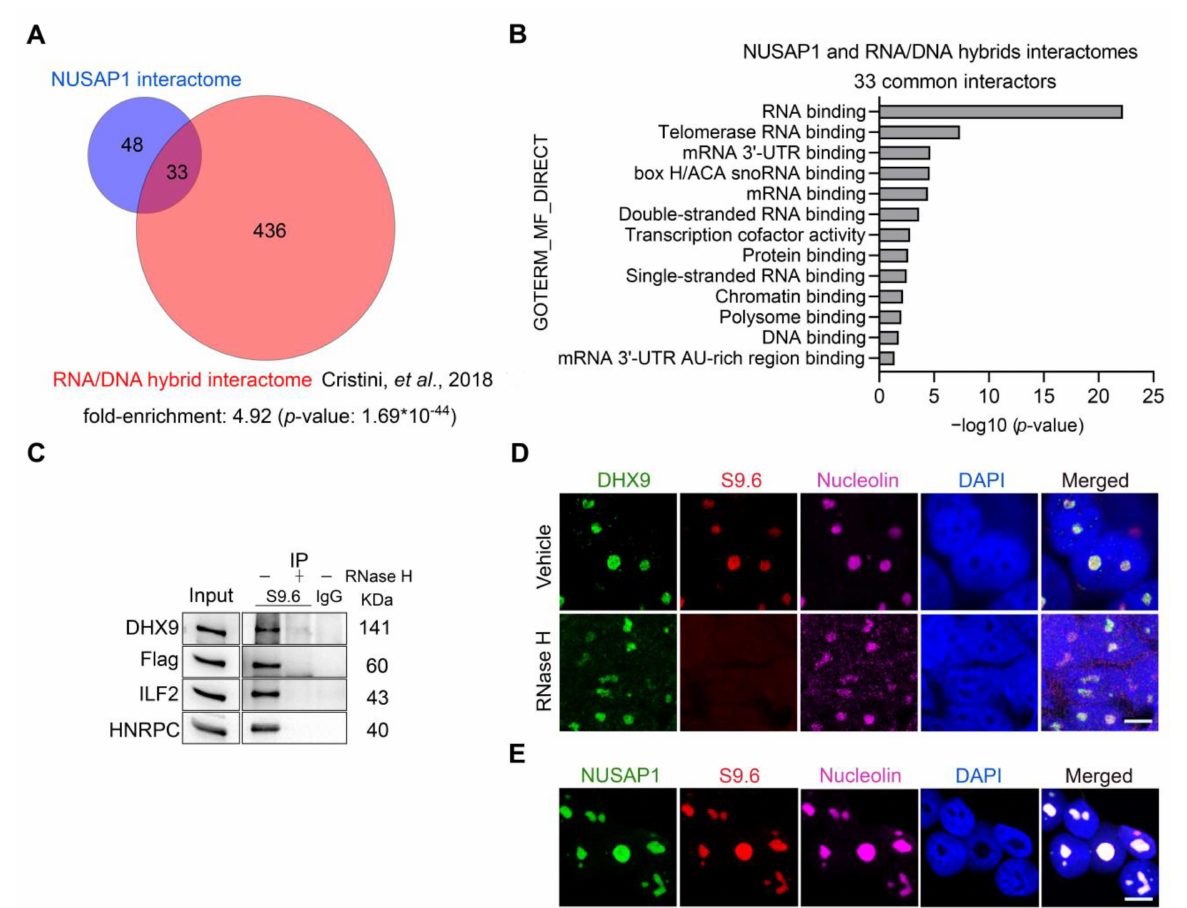
Figure 3. NUSAP1, ILF2, and DHX9 interact with R-loops. ( A ) Venn diagram of 33 proteins found in both NUSAP1 and RNA/DNA hybrid interactomes [41], including ILF2 and DHX9. ( B ) Gene ontology (GO) analysis of the 33 common NUSAP1 and R-loop-interacting proteins shows enrichment for RNA and telomerase RNA binding. ( C ) Immunoprecipitation with S9.6 antibody that binds specifically to RNA/DNA hybrids confirms interactions with DHX9, Flag-NUSAP1, ILF2, and HNRPC. Binding was abolished by pretreatment with RNase H, confirming specificity of their interactions with R-loops. ( D , E ) Confocal microscopy images of pre-extracted LNCaP cells for native NUSAP1, DHX9, nucleolin, and R-loops (S9.6) demonstrate colocalization. Scale bar = 10 µ